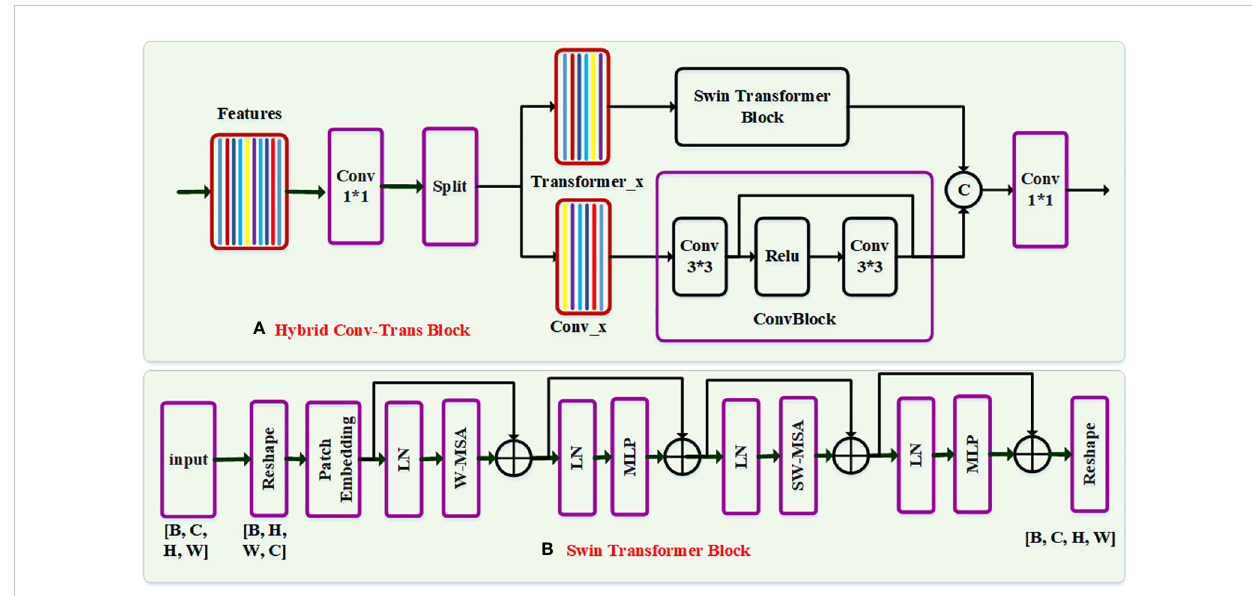
FIGURE 3 The network structure of the Swin-Trans-Conv block. In each block, the input feature is fi rst passed through a 1×1 convolution, and subsequently is split evenly into two feature map groups, each of which is then fed into a Swin transformer block and a residual 3×3 convolutional (RConv) block, respectively. Afterwards, the output features of the Swin-Trans-Conv block and the RConv block are concatenated and then passed through a 1×1 convolution to generate a novel feature via a residual